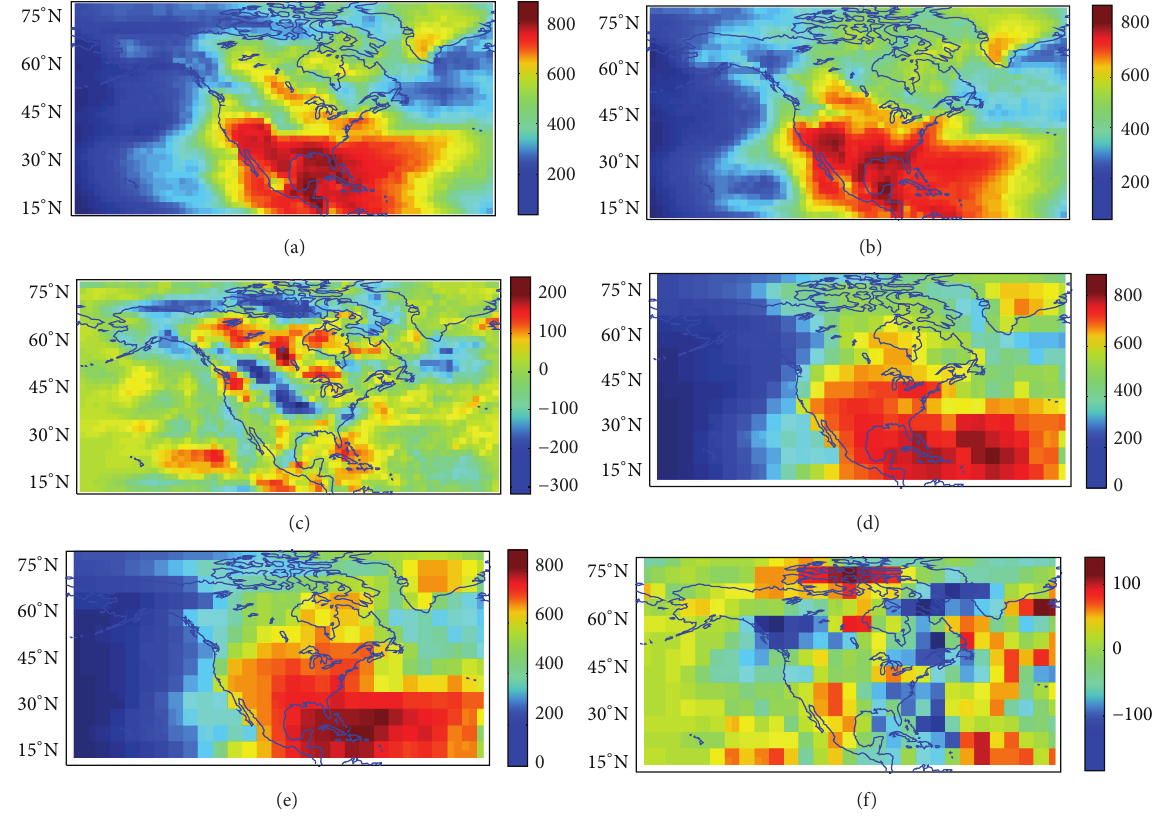
Figure 7: The same with Figure 6 but for the downward shortwave radiation at 9AM local time of US West Coast for July. Panels (a)–(c) are from GFDL CM2.0 and panels (d)–(f) are from MRI CGCM2.3.2 simulations. The color scale with units of W/m 2 is shown on the right for each panel.